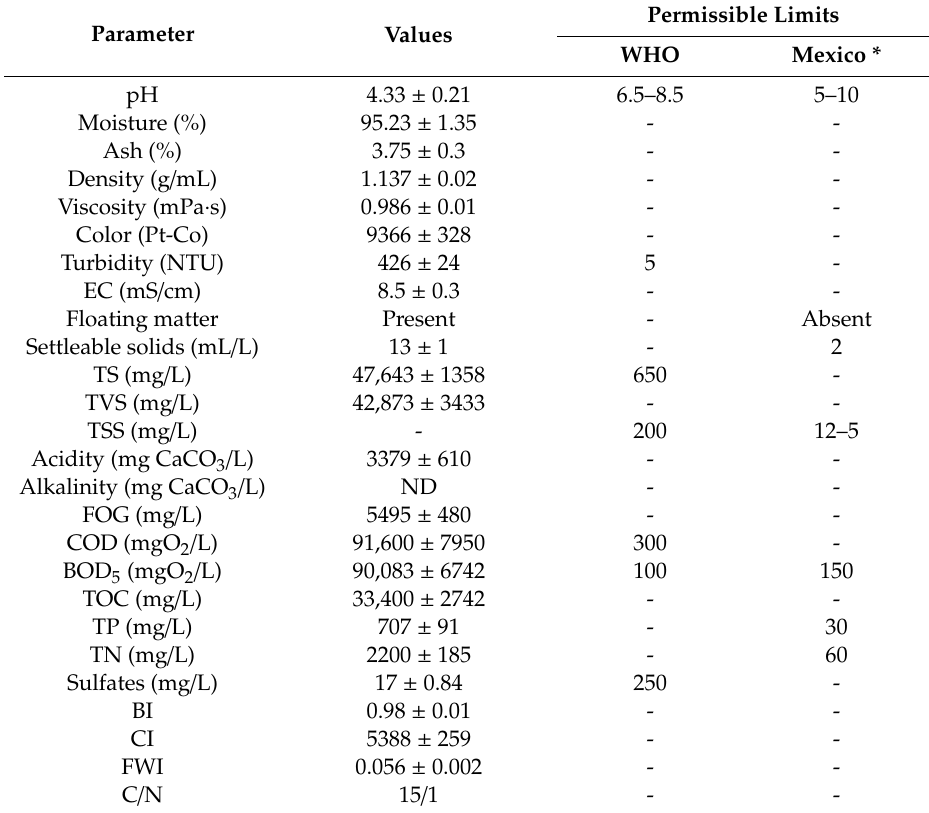
Table 2. Physicochemical characterization of